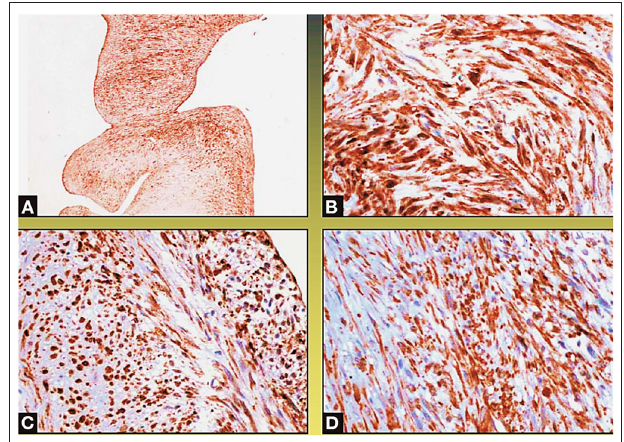
FIGURE 4 | Microscopic view; the neoformation, localized predominantly in the subendocardium, has a polypoid aspect (A,B) , and it consists of monomorphic spindle cells, without atypia, dense proliferation, arranged both in parallel bundles (B) and storiform pattern (C) . Coagulative necrosis was observed in the central part of the tumor (Col. Hem-Eos, original magnification × 10: A,B ; × 40: C,D ).